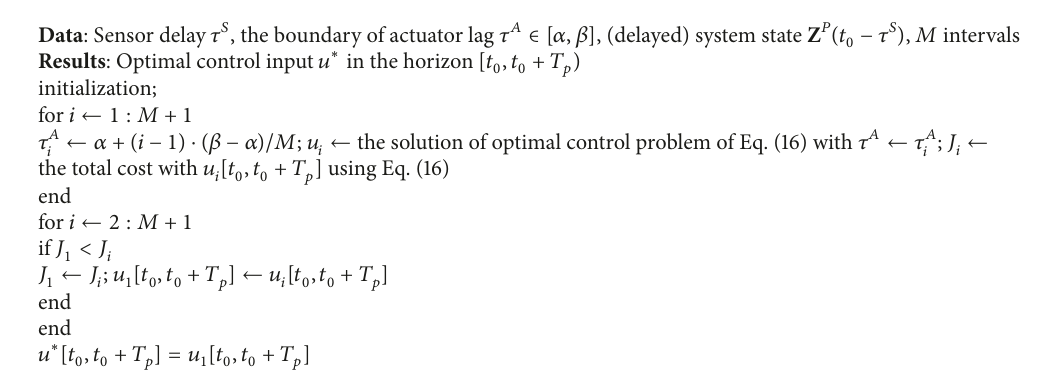
Algorithm 1: The solution for the min-max